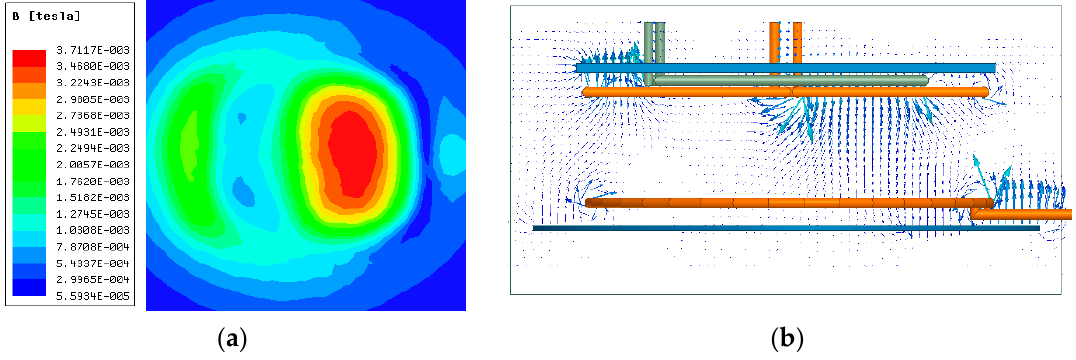
Figure 23. Magnitude plot ( a ) and vector plot ( b ) of the B field between Tx and Rx of the CP–DDQ configuration.